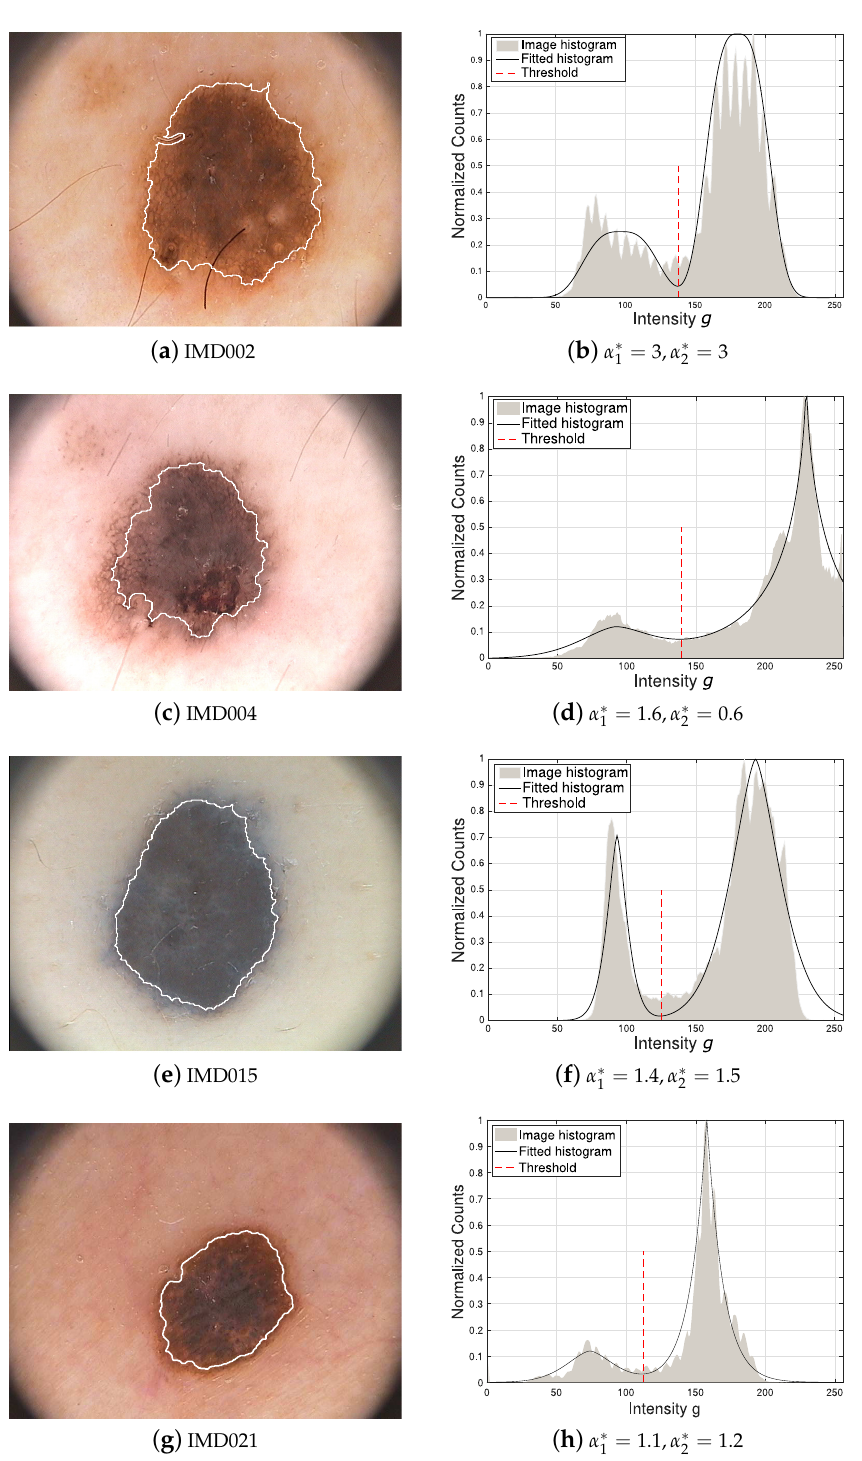
Figure 4. Contours and histograms estimated using the ThCSA algorithm. In the first column, the contour P I is represented with a solid white line. In the second column, the image histogram, fitted histogram, and optimal threshold are displayed with a gray patch, a black solid line, and a red dashed